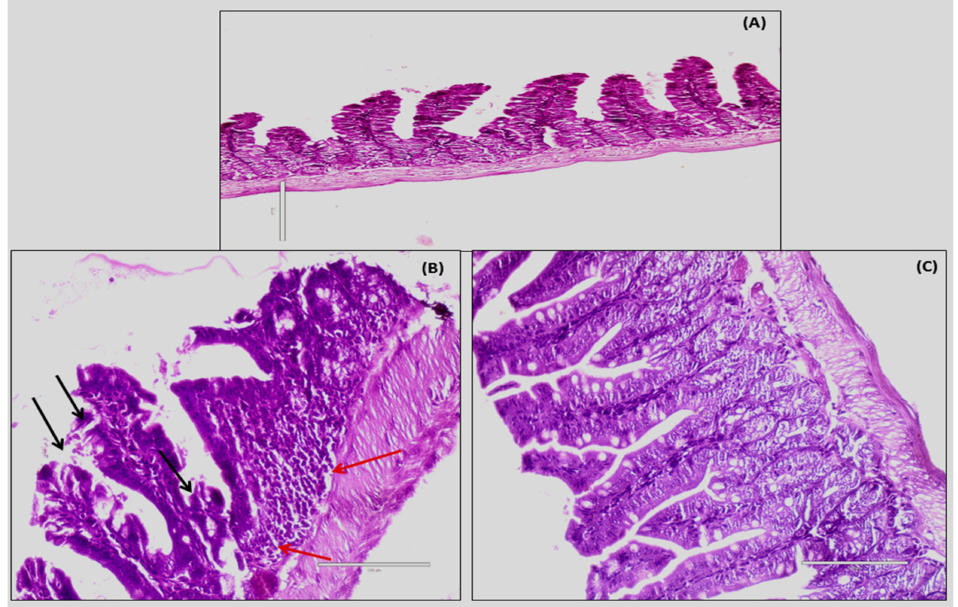
Figure 7. Shows mice intestine treated with PBS as control ( A ) EAEC strain-infected mice intestinal mucosa on 1st day showing disrupted surface epithelium (black arrows) and inflammatory cells (red arrows) ( B ) and mice intestine almost coming back to normal on 15th day after the challenge with the EAEC strain ( C